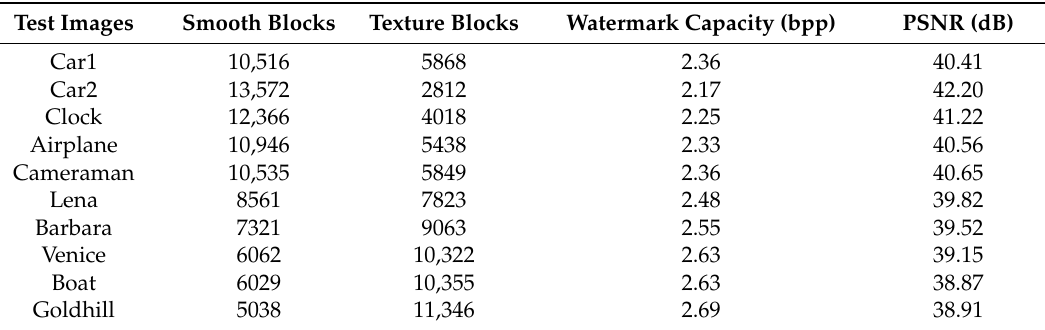
Table 2. The analysis of watermark